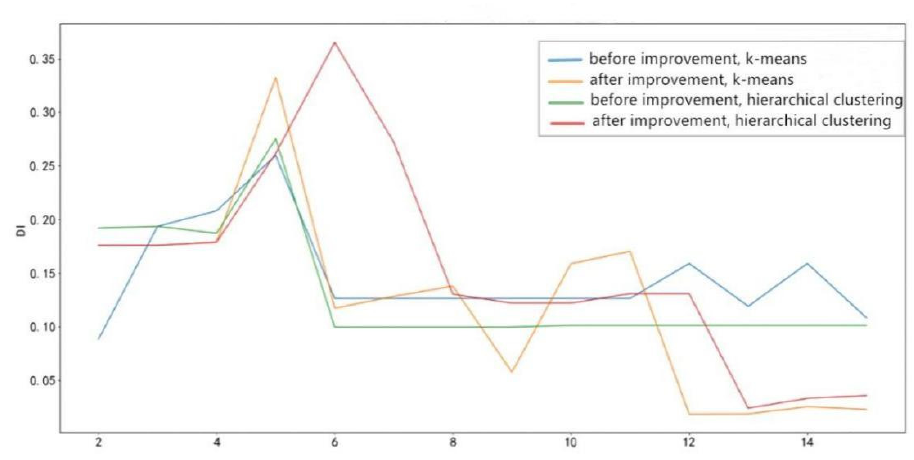
Figure 9. Comparison diagram of clustering DI index before and after improvement.